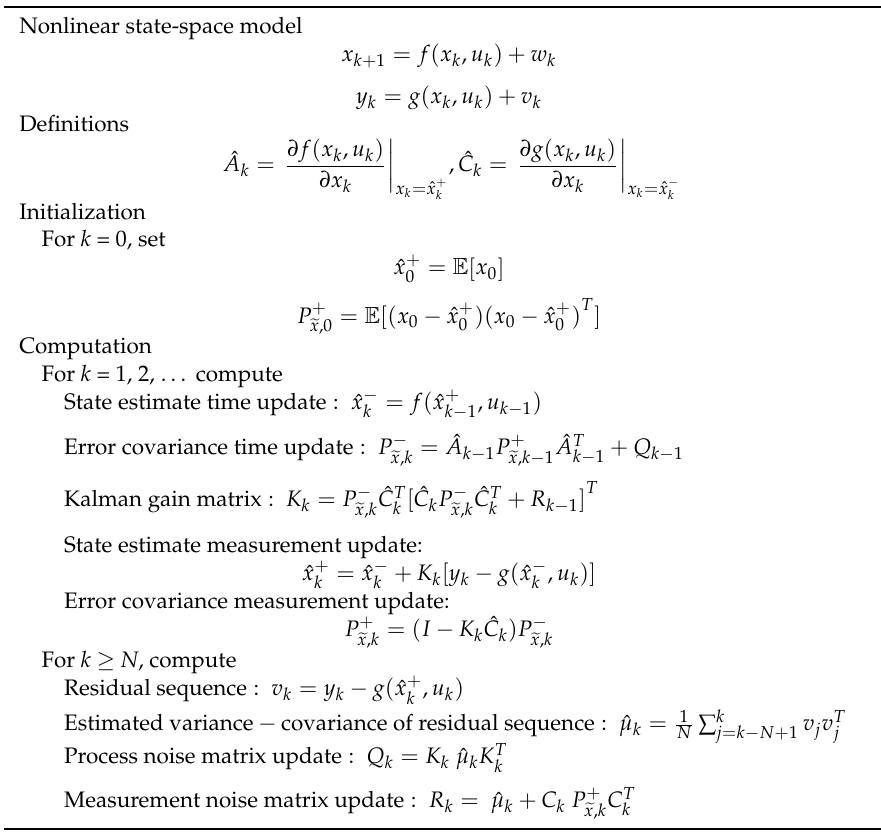
Table 4. Summary of the adaptive extended Kalman filter algorithm